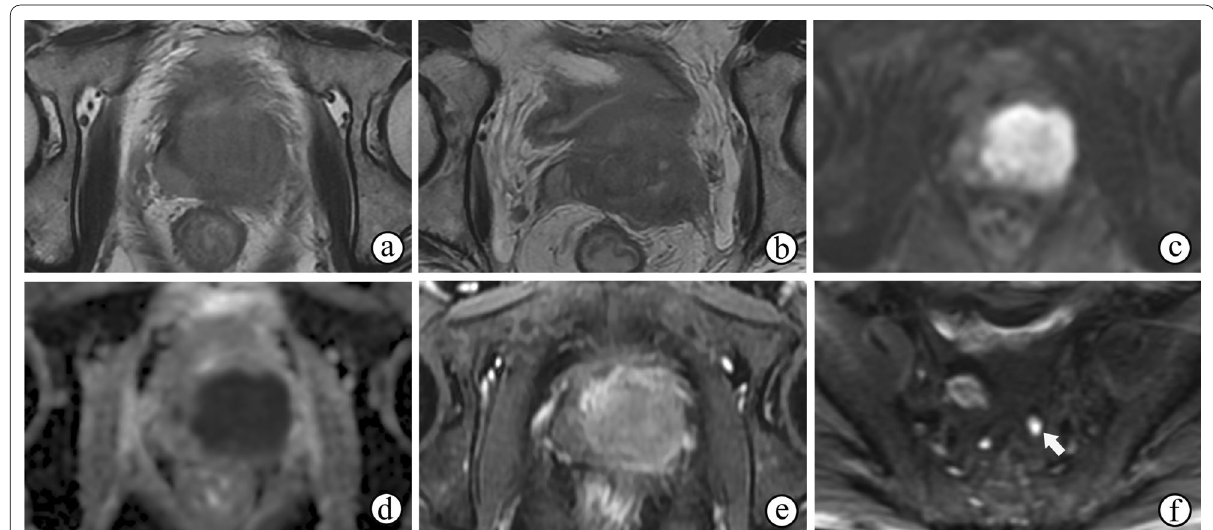
Fig. 16 Secondary diffuse large B cell lymphoma involving the prostate in a 66-year-old male with a normal serum prostate-specific antigen level (0.795 ng/mL) and tear-like pain in the lower abdomen for 1 month. a, b T2WI shows a homogeneously isointense mass in the prostate with extraprostatic extension and invasion of the seminal vesicles. c, d DWI at a b-value of 1400 s/mm 2 and ADC maps show that the mass exhibits